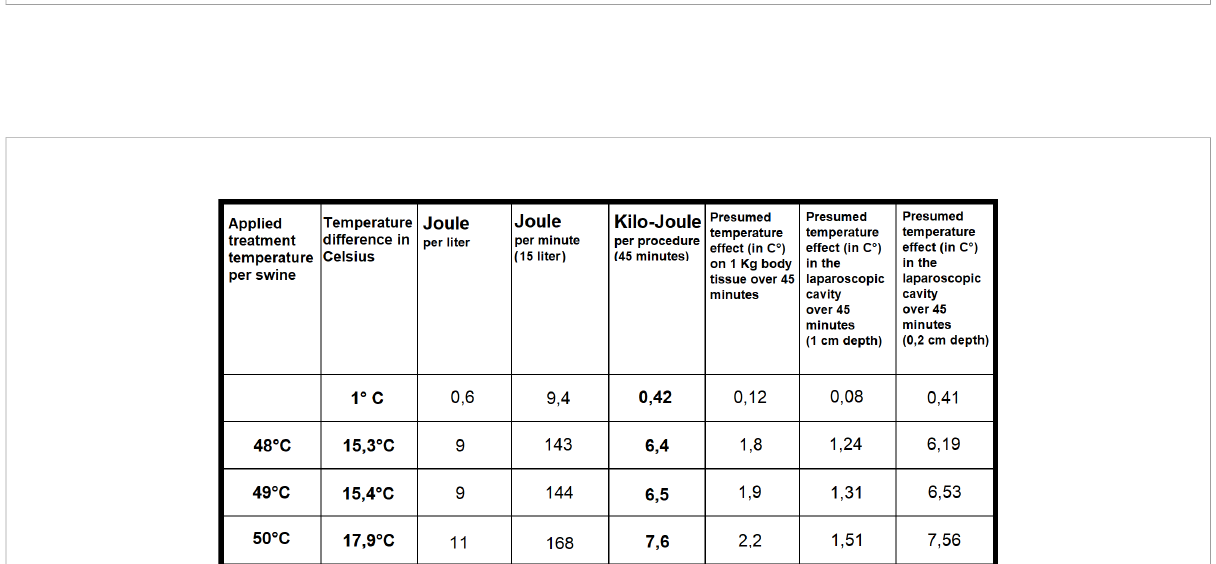
FIGURE 3 Calculated energy transfer during high- fl ow gas-based hyperthermia at 48°C, 49°C and 50°C based on delta (in fl ow and out fl ow temperature difference) and fl